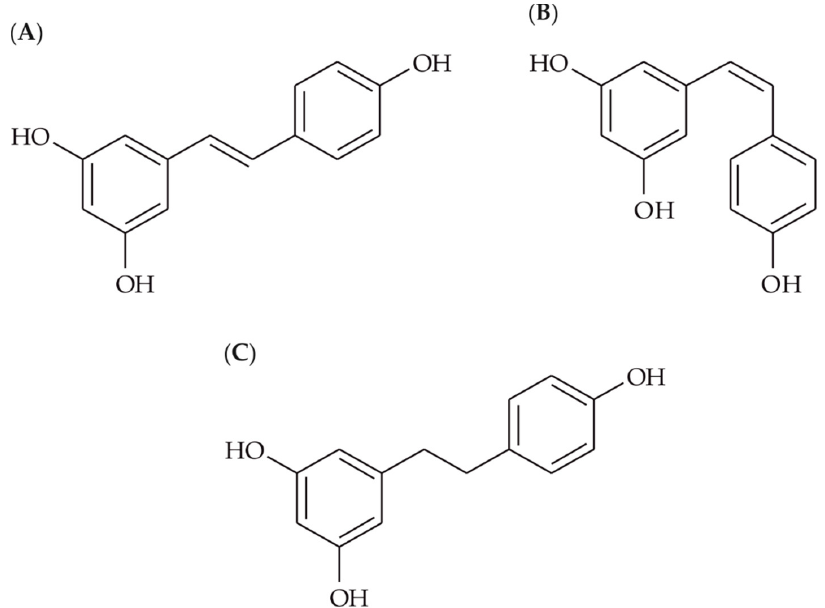
Figure 1. Structures of parent compounds ( A ) trans -resveratrol, ( B ) cis -resveratrol, ( C ) dihydroresveratrol.